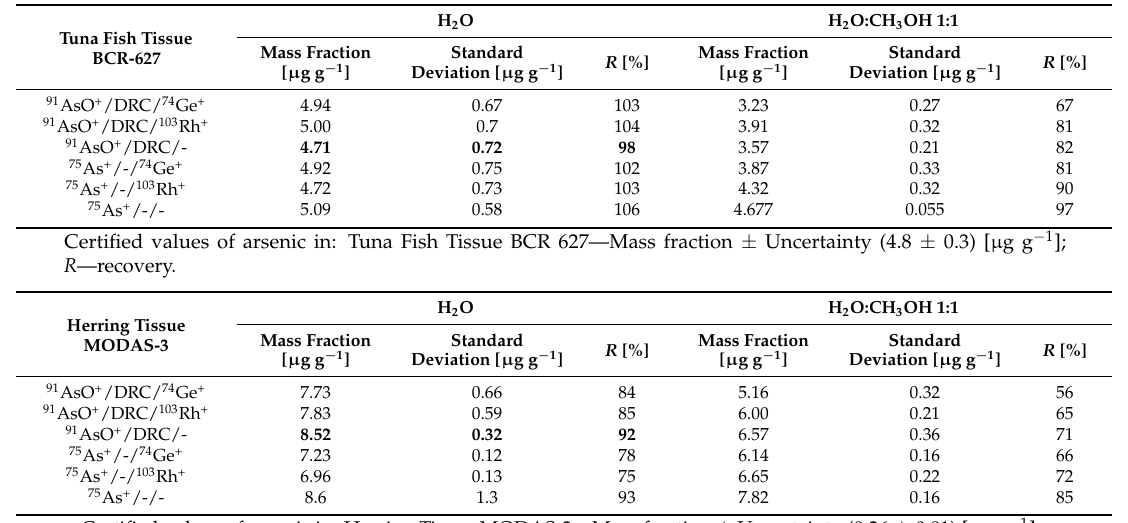
Table 2. Total arsenic concentration in certified reference materials of Tuna Fish Tissue BCR 627 and Herring Tissue MODAS-3 in extracted samples ( n =